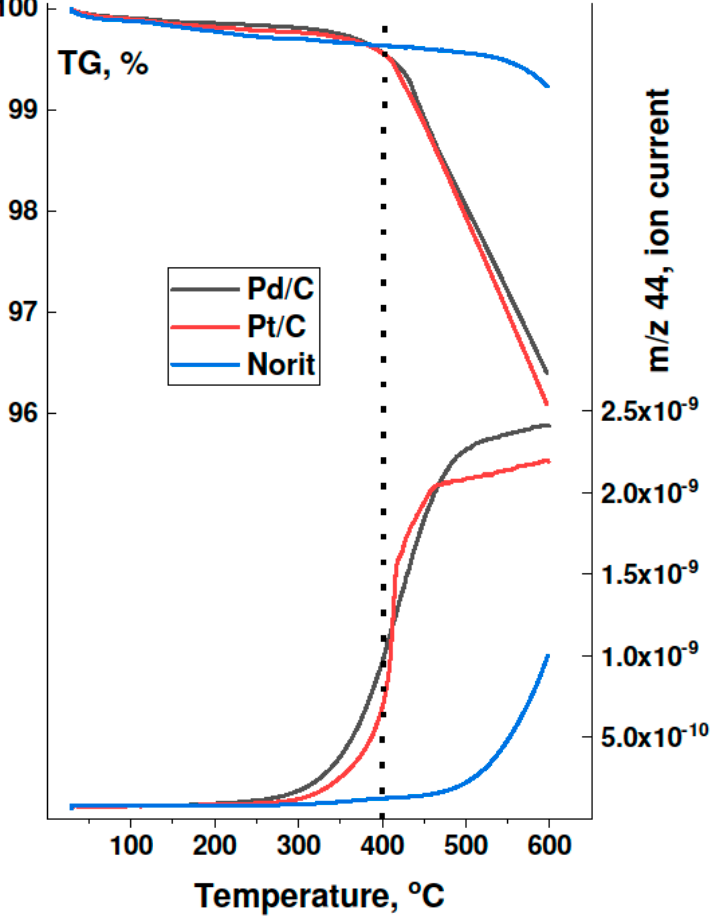
Figure 4. TG-TPO profiles (left axis) of 2 wt % Pd 100 (acac)/Norit1600 (black), 2 wt % Pt 100 (acac)/Norit1600 (red), and Norit 1600 carbon (blue). Evolution of CO 2 (right axis) monitored during TGA-TPO at a 5 °C/min ramp.